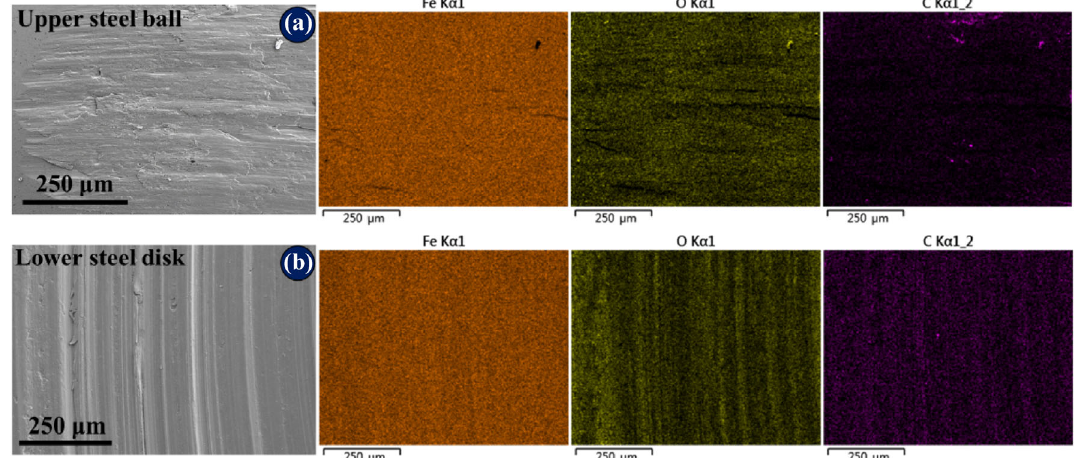
Fig. 14 SEM micrographs and EDS analysis of worn surfaces of an (a) upper steel ball and (b) lower steel disk under MF lubrication at 100 N and 150 °